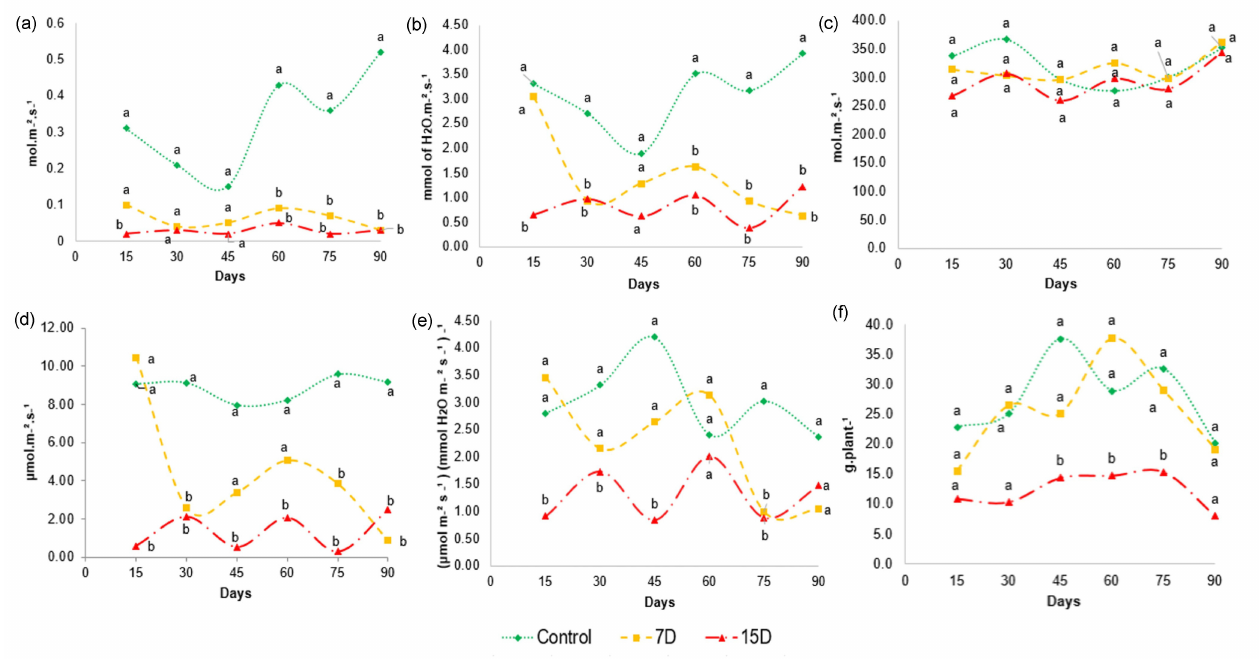
Figure 6. Gas exchange characteristics of Bauhinia ungulata during the 3-month experiment. ( a ) Stomatal conductance— g s , ( b ) transpiration— E , ( c ) intercellular CO 2 concentration— C i , ( d ) photosynthesis— A , ( e ) instantaneous water use efficiency— A/E and ( f ) biomass production. (Tukey’s test; n = 3; p < 0.05). Values sharing the same letters are not significantly different at 5% significance